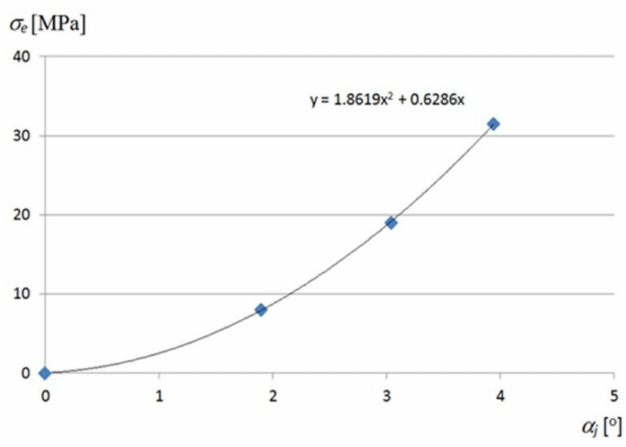
Figure 28. A nonlinear relation between the “effective” σ e stresses and α j unit angle at the crosswise ends of an effectively twisted